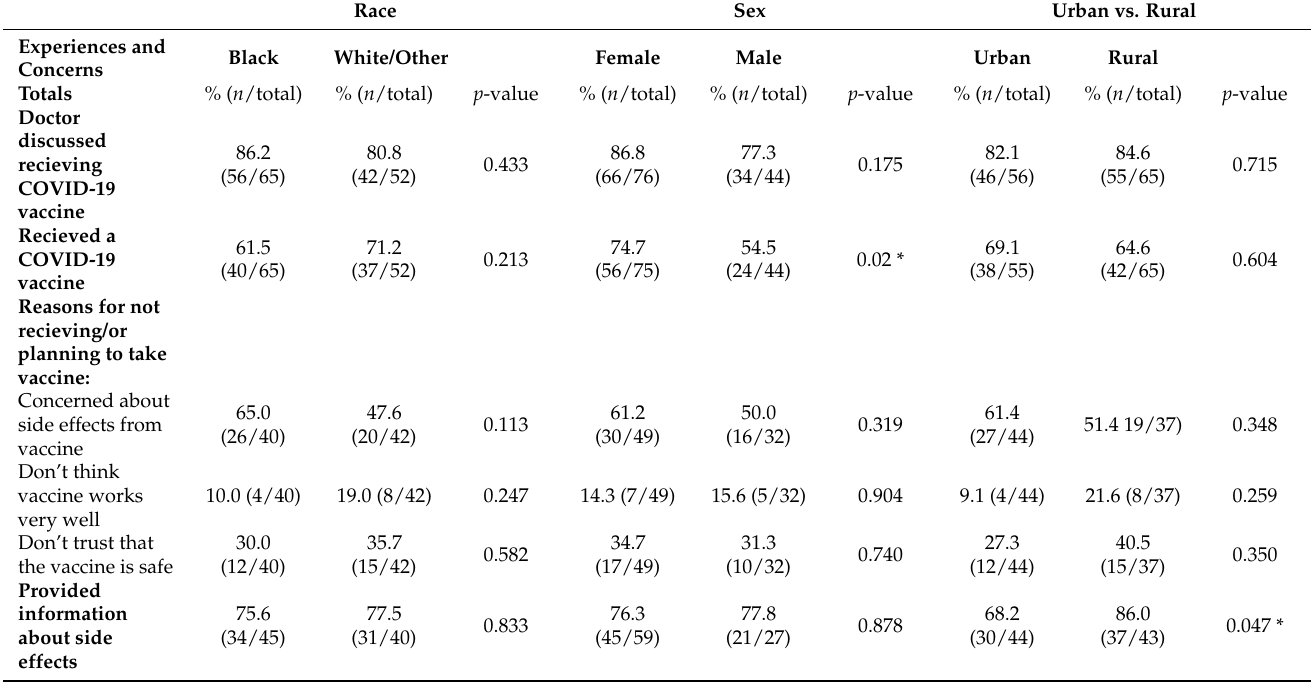
Table 2. COVID-19 Vaccine Experiences and Concerns by Race, Sex, and Place of Residence. Race Sex Urban vs.